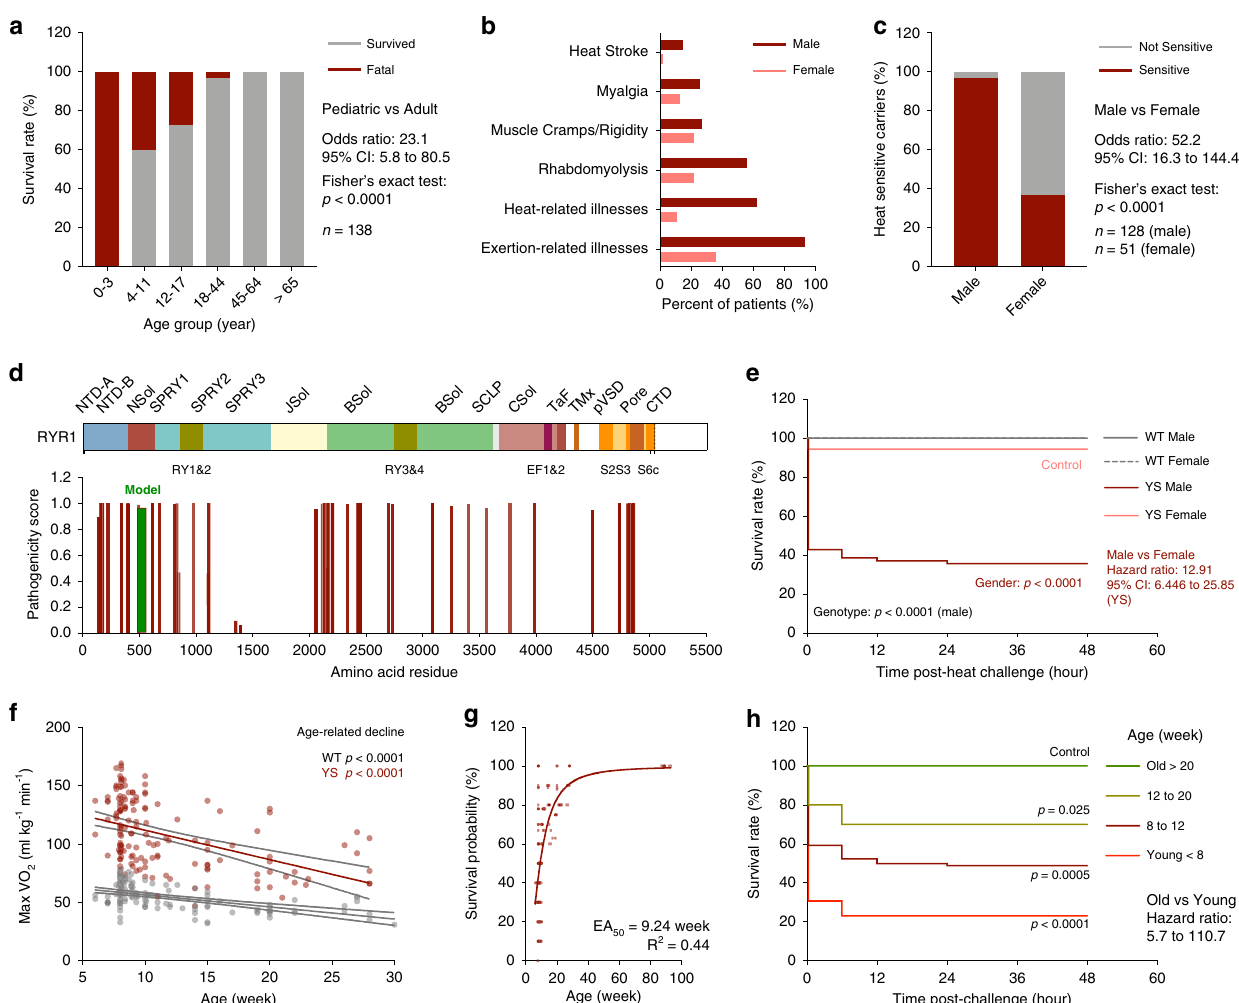
Fig. 1 Heat intolerance in patients and mice with RYR1 pathogenic variants associated with malignant hyperthermia susceptibility (MHS). a Survival rate of heat intolerant patients carrying RYR1 variants associated with MHS among age groups. b Symptoms associated with heat intolerance in male and female carriers. c Proportion of symptomatic carriers with heat-intolerant symptoms in male and female carriers. d Pathogenicity of RYR1 variants associated with heat-sensitivity. e Kaplan – Meier analysis of the survival rate of WT ( n = 50, male and n = 12, female) and YS ( n = 70, male and n = 18, female) mice after acute heat challenge. f Relationship of the age of mice and maxVO 2 during acute heat challenge in WT ( n = 125) and YS ( n = 151) mice. g Effect of age on the estimated survival probability of YS mice ( n = 159) after acute heat challenge. h Kaplan – Meier analysis of the heat challenge survival rate of YS mice ( n = 124) grouped by age. All mice were housed at room ambient temperature (20.2 ± 0.4 °C) prior to heat challenge. All mice were within the controlled age range (8.9 ± 0.9 week old) at the time of the study, except for the age-dependent experiments ( f – h ). P values are indicated as analyzed by Fisher ’ s exact test ( a , c ), Mantel – Cox log-rank test ( e , h ), and F -test for deviation from zero-slope of linear regression ( f ). All statistical tests are two- sided. R 2 values are indicated to quantify goodness-of- fi t to non-linear regression with variable slope ( g ). Data are represented as mean ± 95% con fi dence intervals (CI) from the linear best- fi t line ( f ). Survival probability of each muse is estimated based on the survival rate from ten mice in the respective age subgroups ( g ). Effect of age of the YS mice on survival of the heat challenge was determined by assessing survival probability as a function of age. The EA 50 is de fi ned as the half-maximal effective age ( g ). The effect of age on survival of individuals (panel a ) with RYR1 mutations was also assessed. The pediatric subgroup is de fi ned as 17 years of age and younger, and the adult subgroup is de fi ned as 18 years of age and older. Sample sizes, odds ratios, and 95% con fi dence intervals (CI) are indicated. Source data are provided as a source data fi